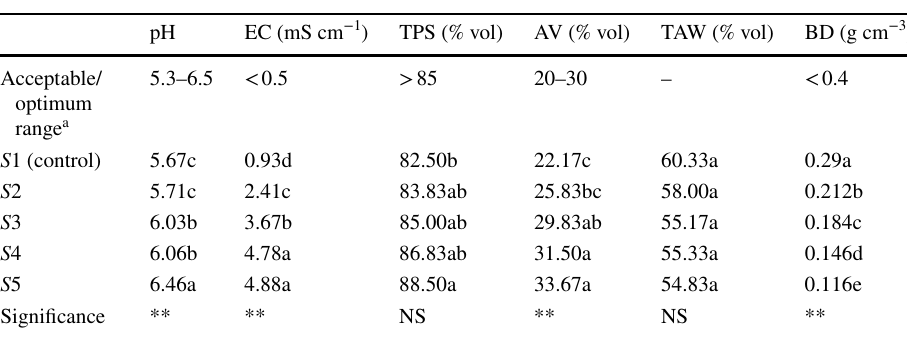
Table 1 Pysico-chemical properties of the growing